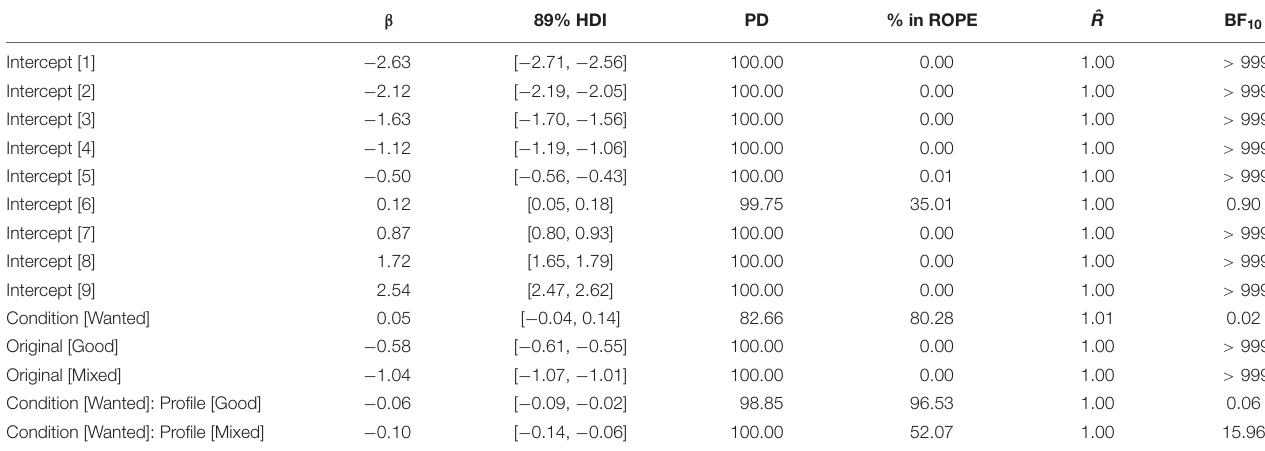
TABLE 14 | Summary of the model fitted to the trustworthiness ratings, considering the experimental condition (Avoided or Wanted) and Profile type (Good, Mixed, and